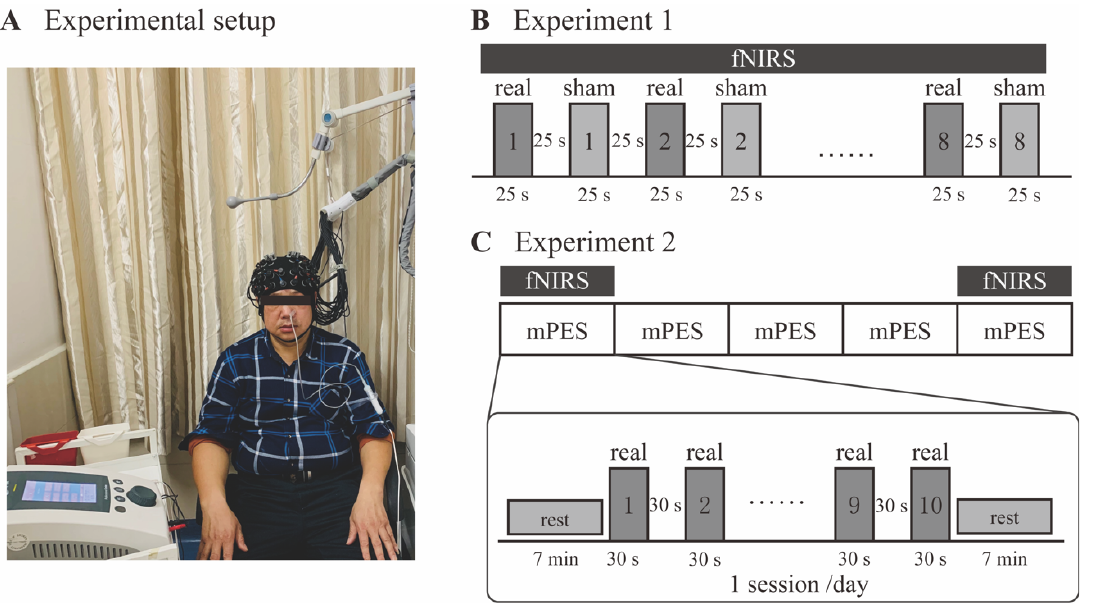
Figure 2. Experimental design. ( A ) A participant sitting on the chair after setting of the mPES electrodes and the fNIRS cap. ( B ) The procedure of Experiment 1. Real and sham mPES were delivered alternately in blocks (repeated 8 times), while the order of real and sham at the onset of mPES was randomized. Each block lasted 25 s, followed by 25 s rest. fNIRS signals were recorded concurrently. ( C ) The procedure of Experiment 2. Participants received mPES for 5 sessions (1 session/day). fNIRS signals were recorded during mPES on the 1st and 5th days. For each session, real mPES were delivered in blocks (repeated 10 times). Each block lasted 30 s, followed by 30 s rest. mPES modified pharyngeal electrical stimulation; fNIRS functional near-infrared spectroscopy.